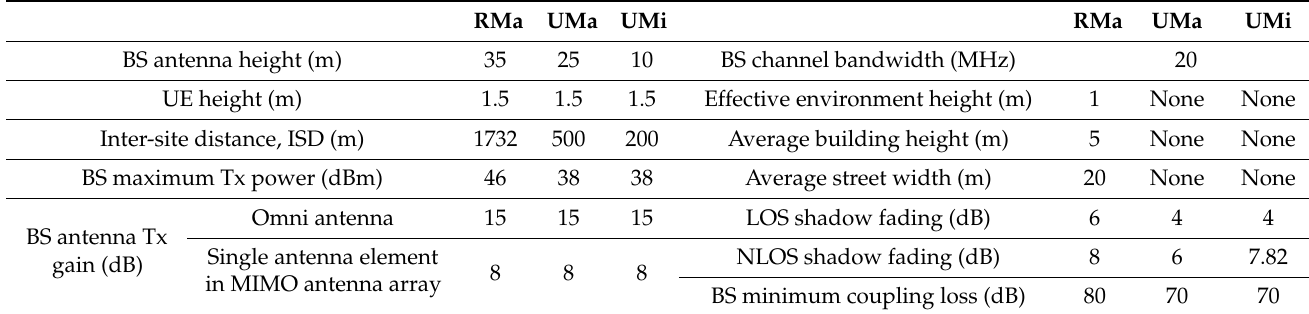
Table 3. Cellular BS and environmental parameters [14–16].